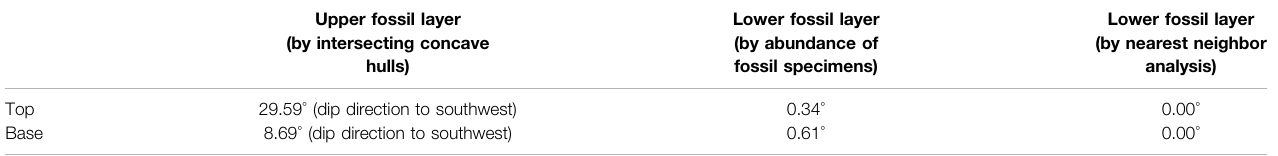
TABLE 4 | Maximum dip angles of the top and base planes of both fossil layers identi fi ed herein relative to the Navesink-Hornerstown formational contact. For comparison, the structural dip of the Hornerstown Formation has been previously reported as ranging from 0.08 ° to 0.12 ° (Steckler et al., 1999; Esmeray-Senlet et al., 2015). Upper fossil layer (by intersecting